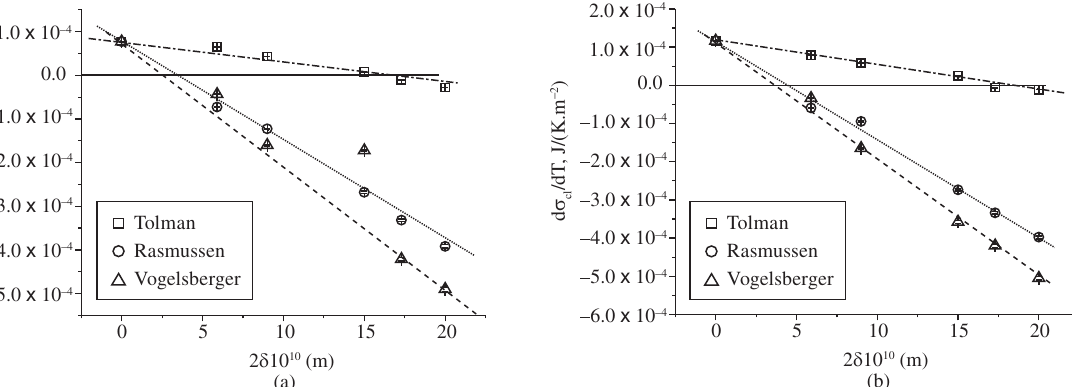
Figure 5. d σ /dT as function of δ for a N cl b) induction time.